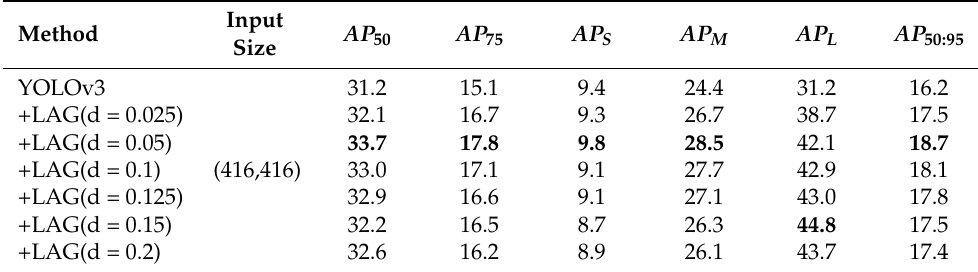
Table 1. Ablation results on different